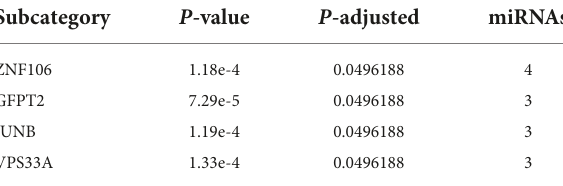
TABLE 7 Target gene of enrichment analysis of 10 dysregulated miRNAs. Subcategory P -value P -adjusted